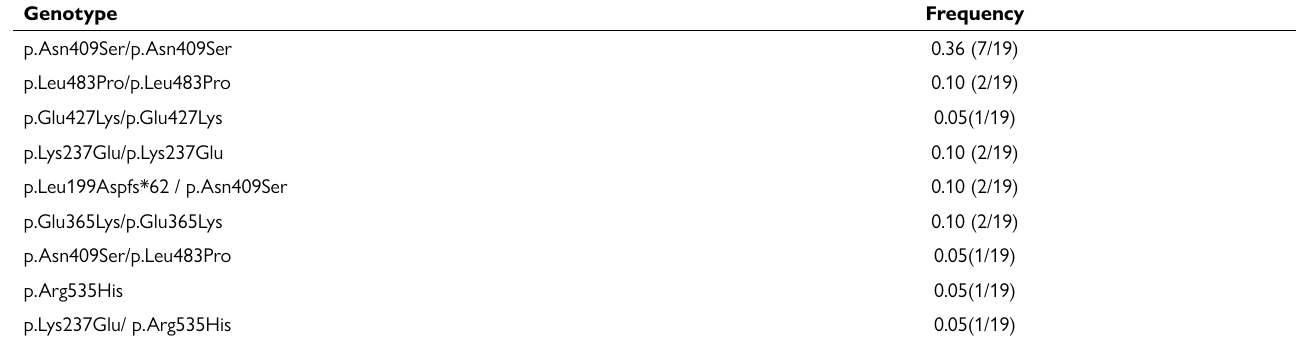
Table 3. Genotypic frequency found in patients diagnosed with GD.